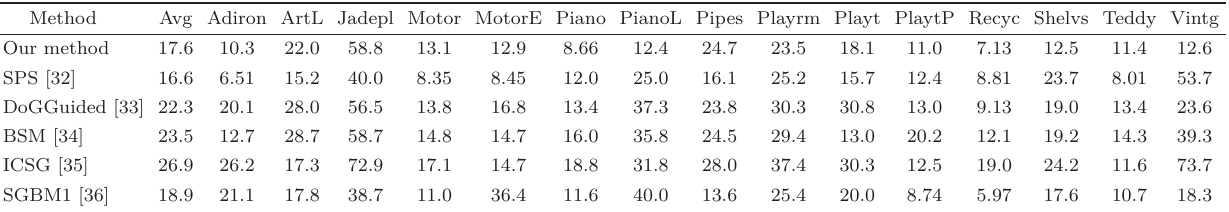
Table 5 Performance comparison of quantitative evaluation results based on all error from MV3